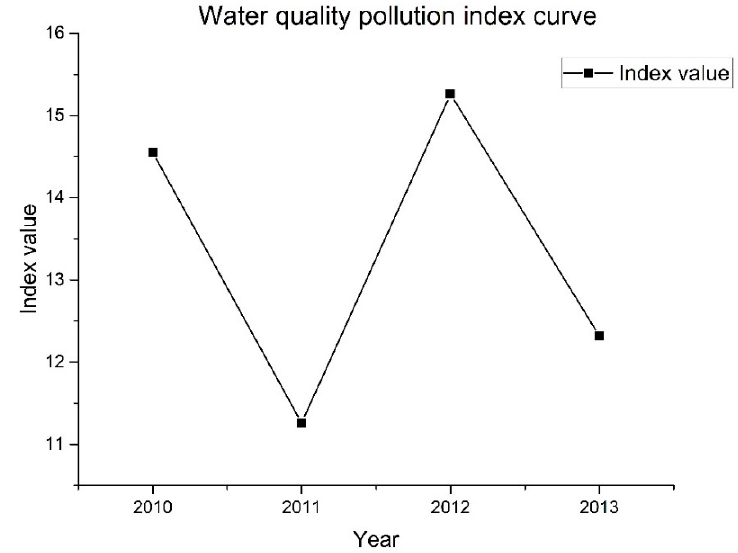
Figure 5. The water quality pollution index curve.